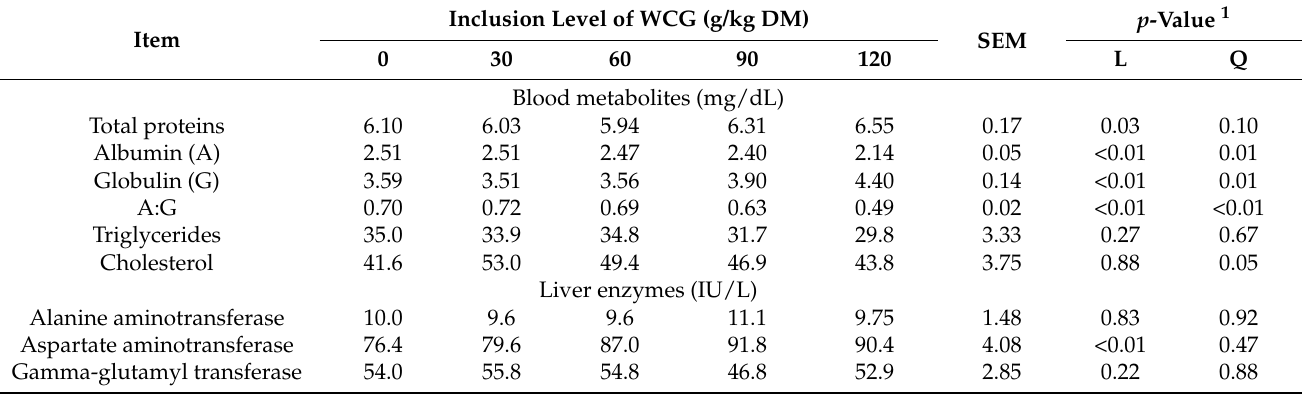
Table 4. Concentration of metabolites and liver enzymes in the blood of lambs fed diets containing whole corn